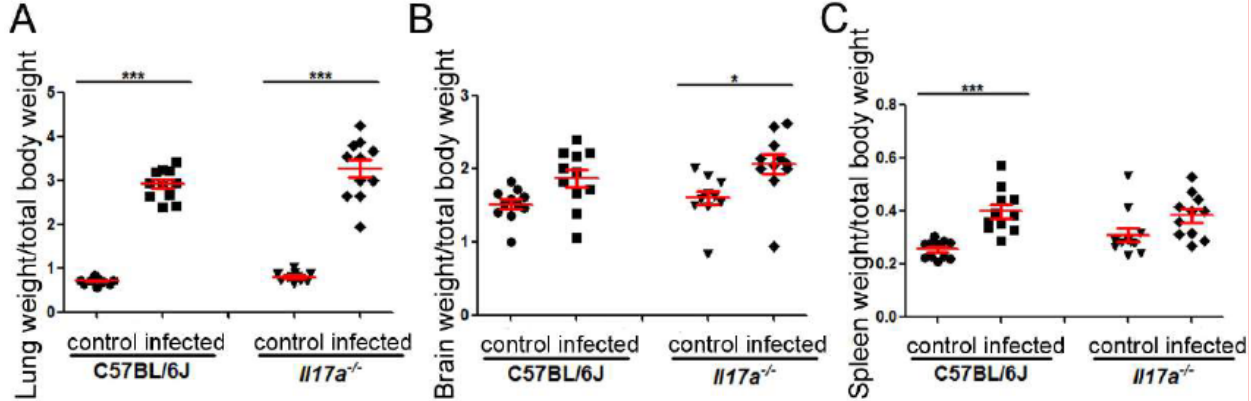
Figure 3. Effect of C. neoformans on target organ size in C57BL/6J and Il17a -/- animals. Weight of lungs ( A ), brains ( B ), and spleens ( C ) relative to total weight of mouse in C57BL/6J and Il17a -/- mice after 9 days of infection with H99 strain of C. neoformans . Asterisks indicate significant differences.